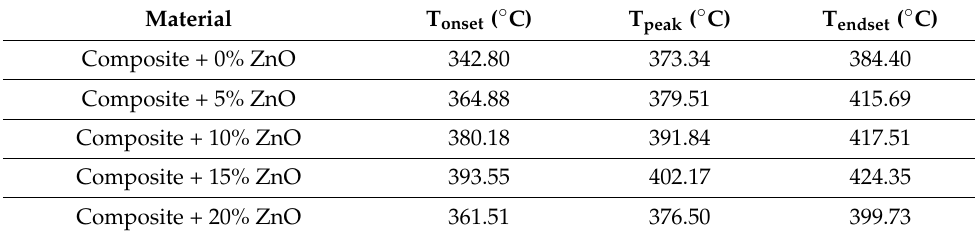
Figure 11. Graph of differential scanning calorimetry (DSC) at different variations of ZnO. Table 5. Differential scanning calorimetry (DSC) test